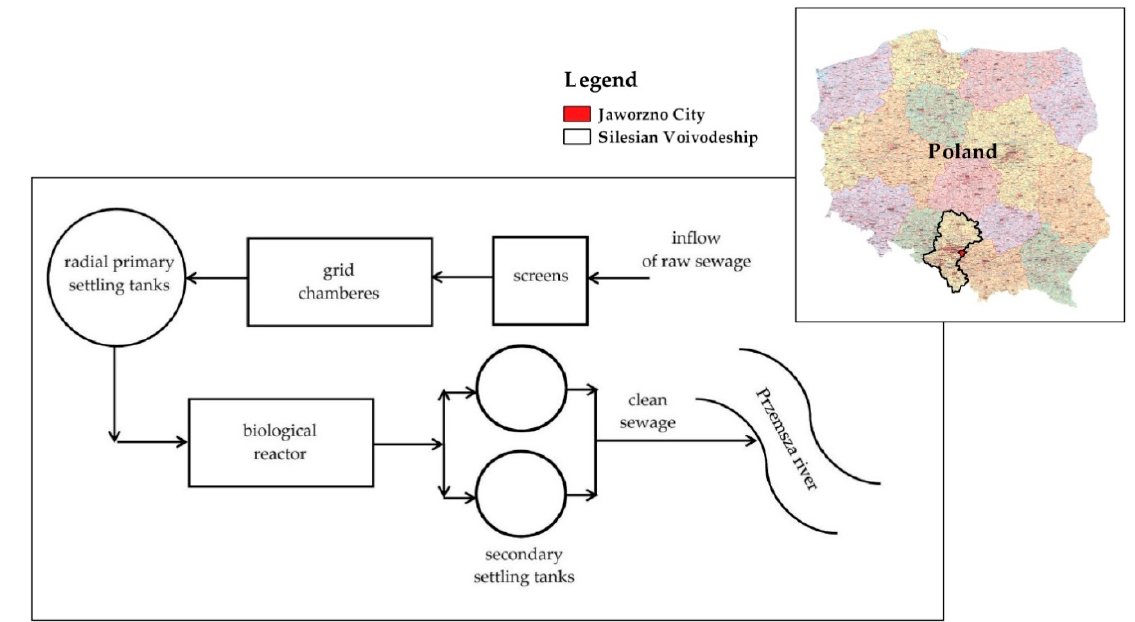
Figure 1. A simplified scheme of the wastewater treatment plant in Jaworzno.